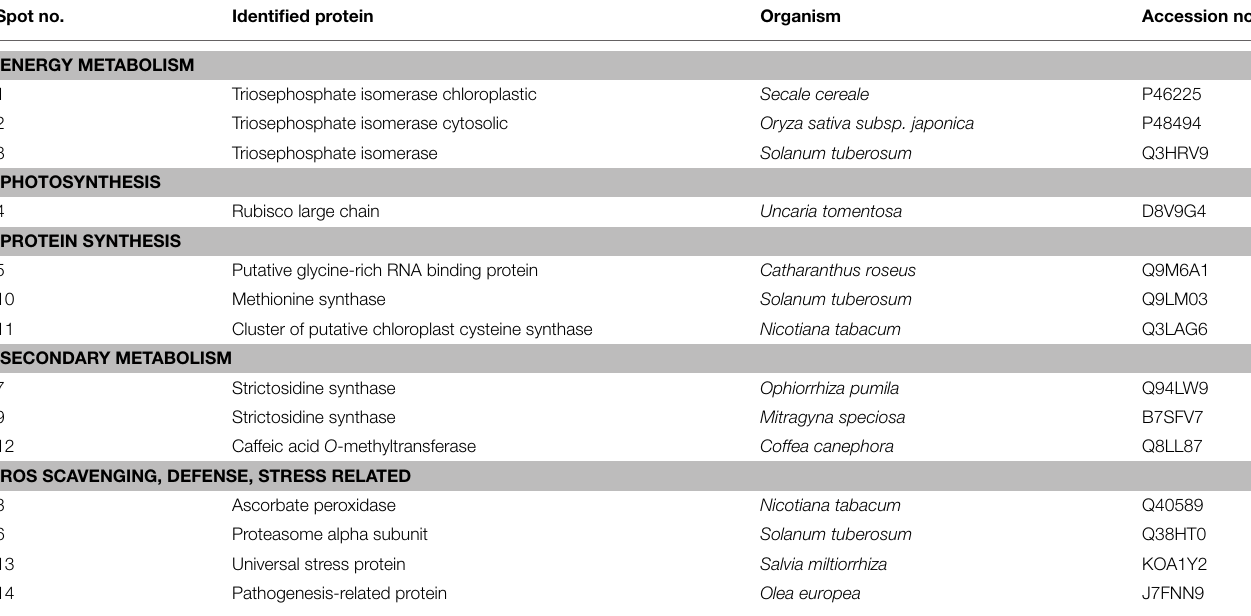
TABLE 2 | Protein identification through MALDI-TOF from Uncaria tomentosa root cultures under BSO-JA treatment. Spot